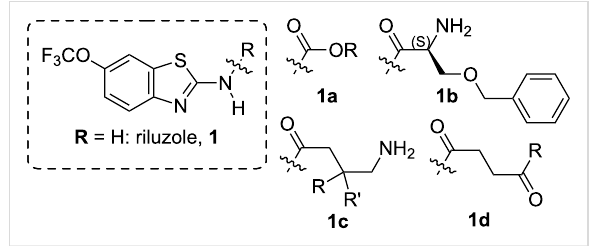
Figure 2: Riluzole (left) and prodrugs developed by McDonnell et al. [11].